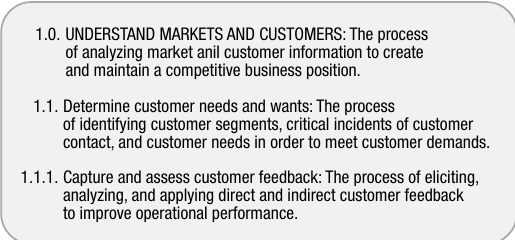
Fig. 1. Three levels of process understanding markets and customers in the PWC-PCF Source: PWC